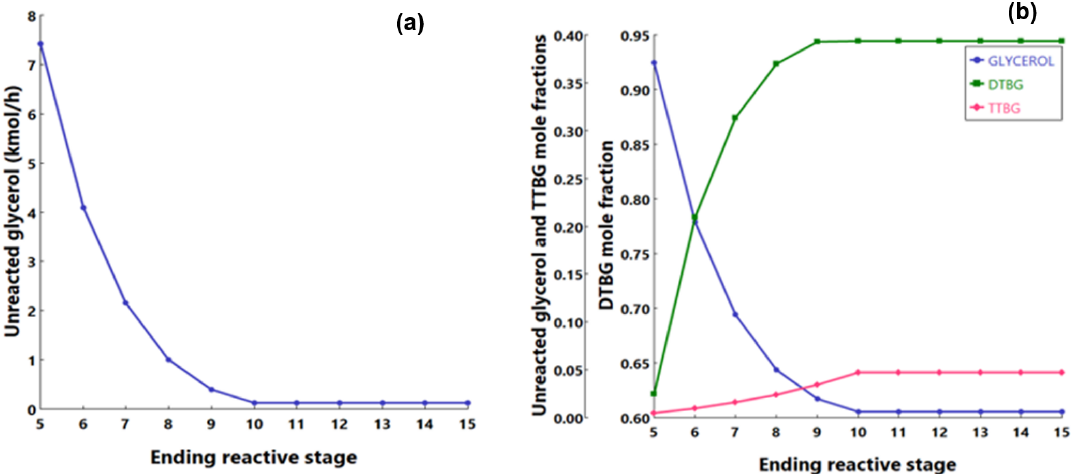
Figure 9. For Reflux ratio = 1.1, TBA:Gly = 5, ( a ) Unreacted glycerol flow rate at the bottom stream as a function of reactive stages. ( b ) Glycerol, DTBG, and TTBG mole fractions in the bottom stream as a function of reactive stages.